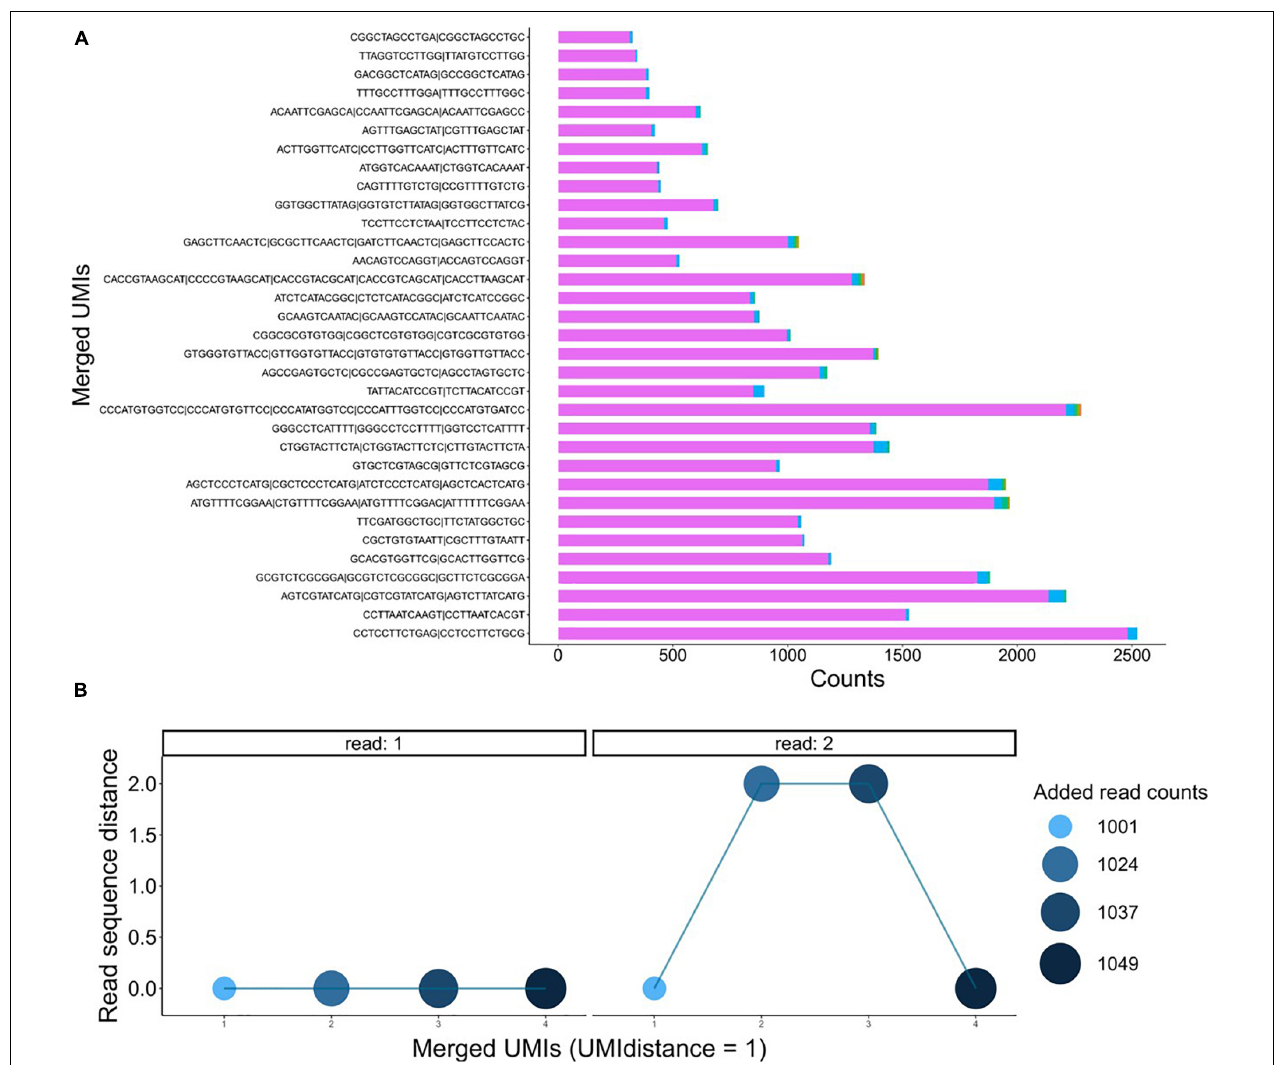
FIGURE 6 | (A) Bar plots showing the number of reads on the merged UMIs. (B) Dot plots of a group of four UMIs on the x -axis and the distance of the reads on the y -axis on R1 and R2. The density and the size of the dots represent the number of reads after